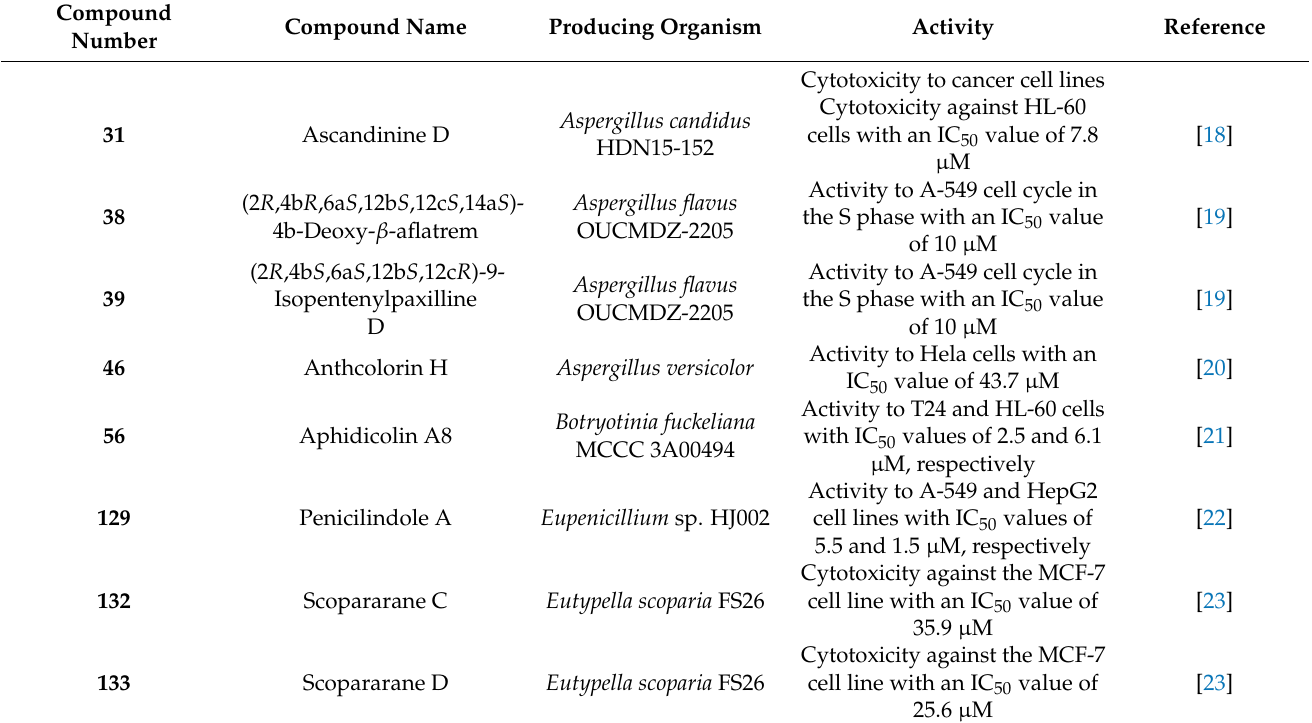
Table 1. Marine fungi ‐ derived compounds with various bioactivities.